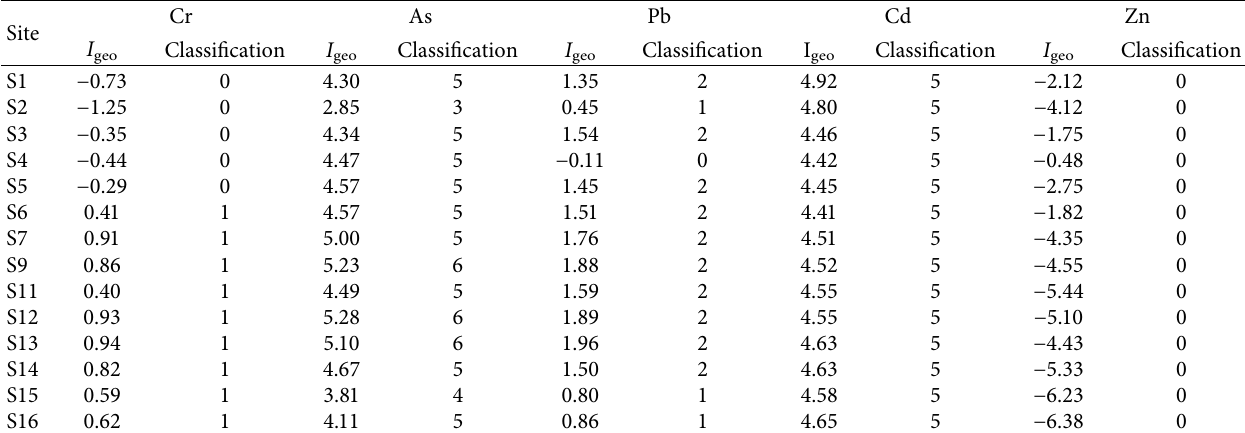
Figure 5: The column chart of the potential ecological risk index (RI) of heavy metals in sediments. Table 4: Geoaccumulation index and pollution classification of heavy metals in